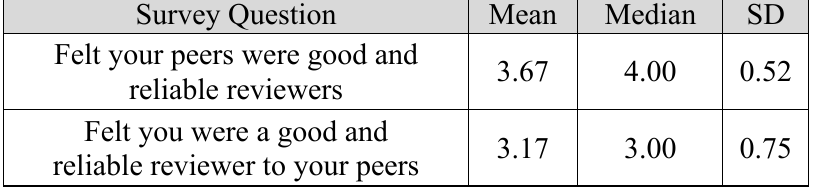
Descriptive Statistics of Student Attitudes Regarding Reviewer